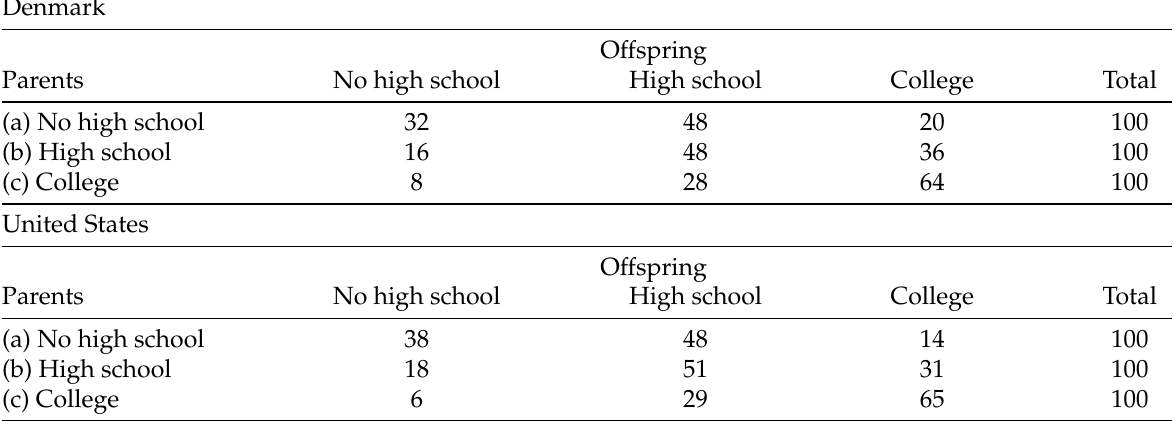
Table 1: Reproduction of final panel in Table 2 in Andrade and Thomsen (2018)